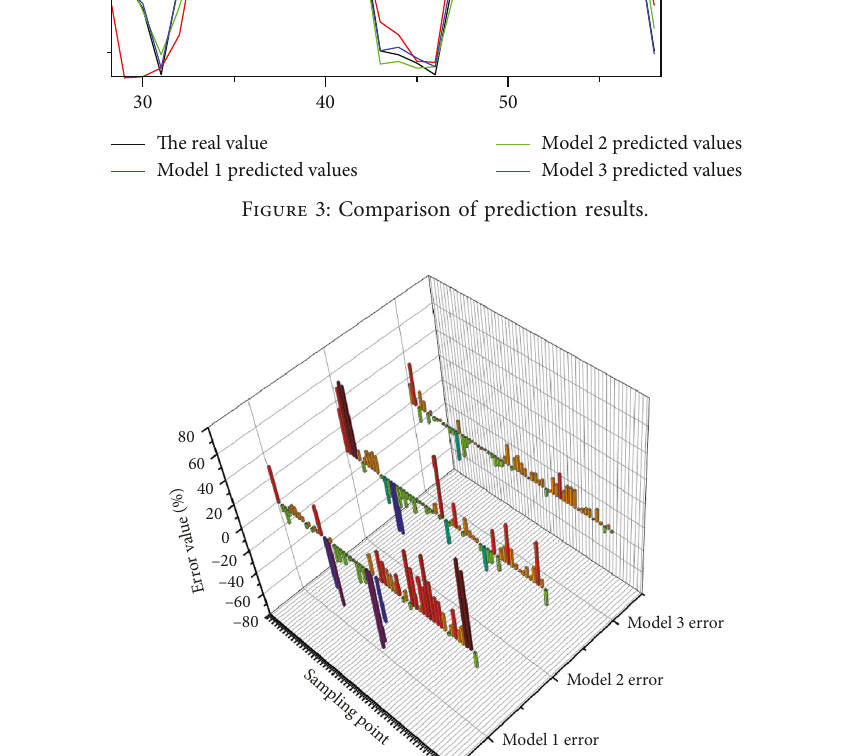
Figure 4: Comparison of prediction